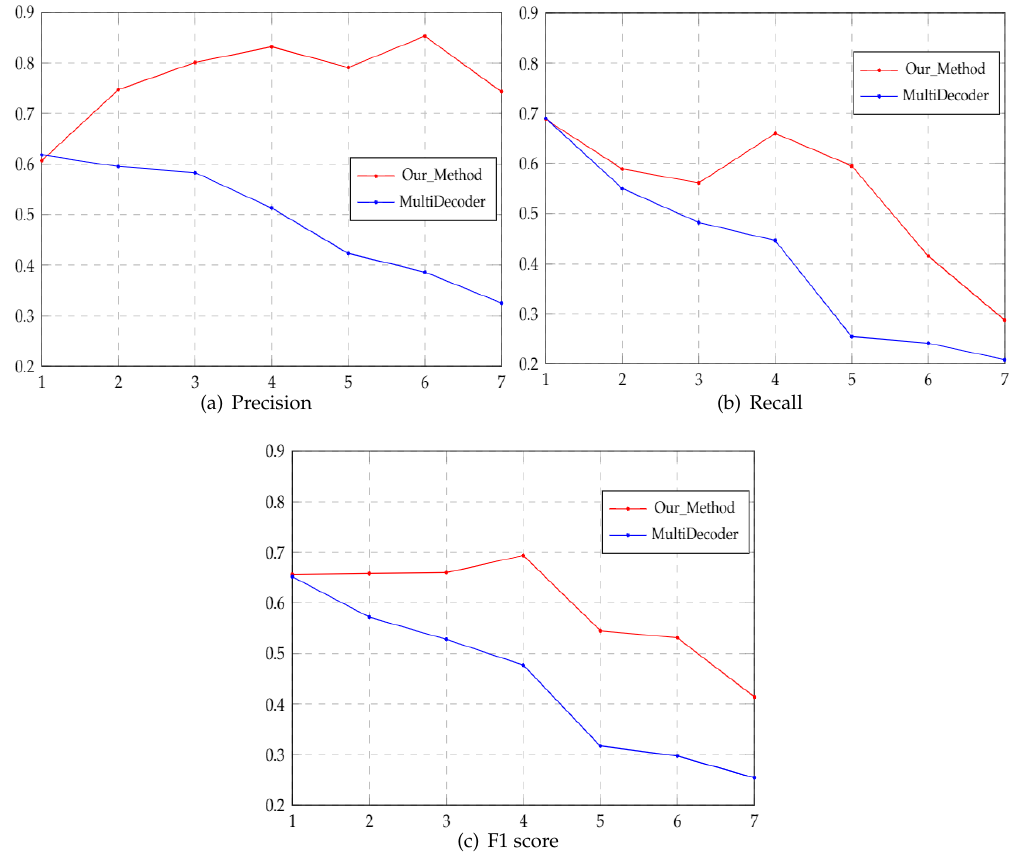
Figure 4. Results of Precision, Recall and F1 score of sentences that contains different number of triplets of our model and MultiDecoder on NYT11